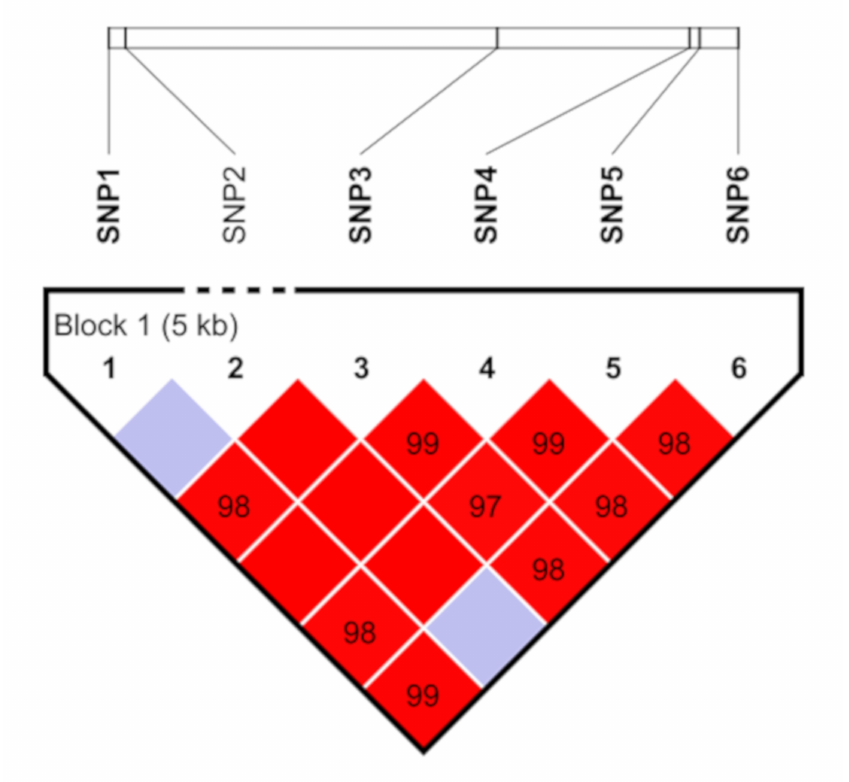
Figure 4. Linkage disequilibrium analysis of 6 single nucleotide polymorphisms